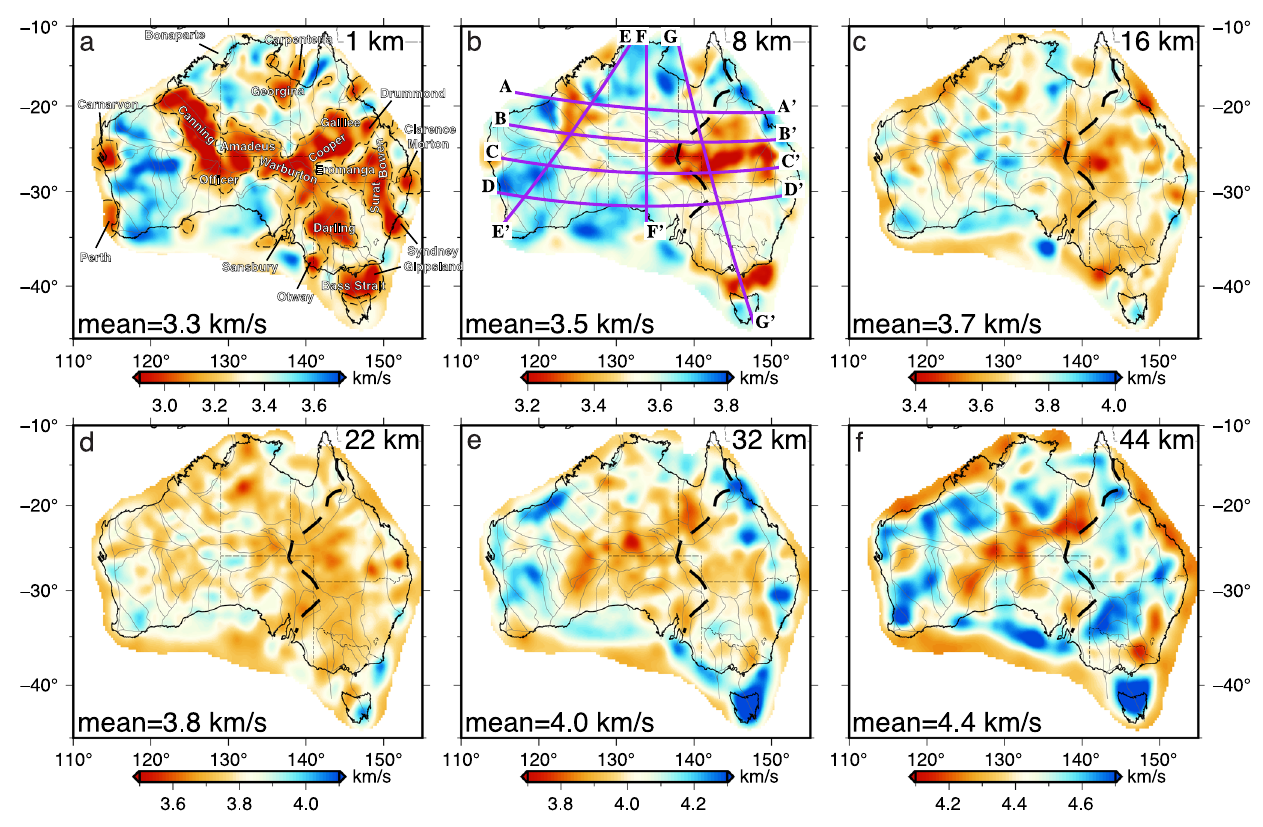
Fig. 4 | Shear velocities at six depth ranges. The black dashed lines in a indicate thevelocitycontourof3.3km/s.Majorsedimentarybasinsarelabeled.Thelocation of the proposed Tasman line from ref. 25 is marked by the black dashed line in b – f .